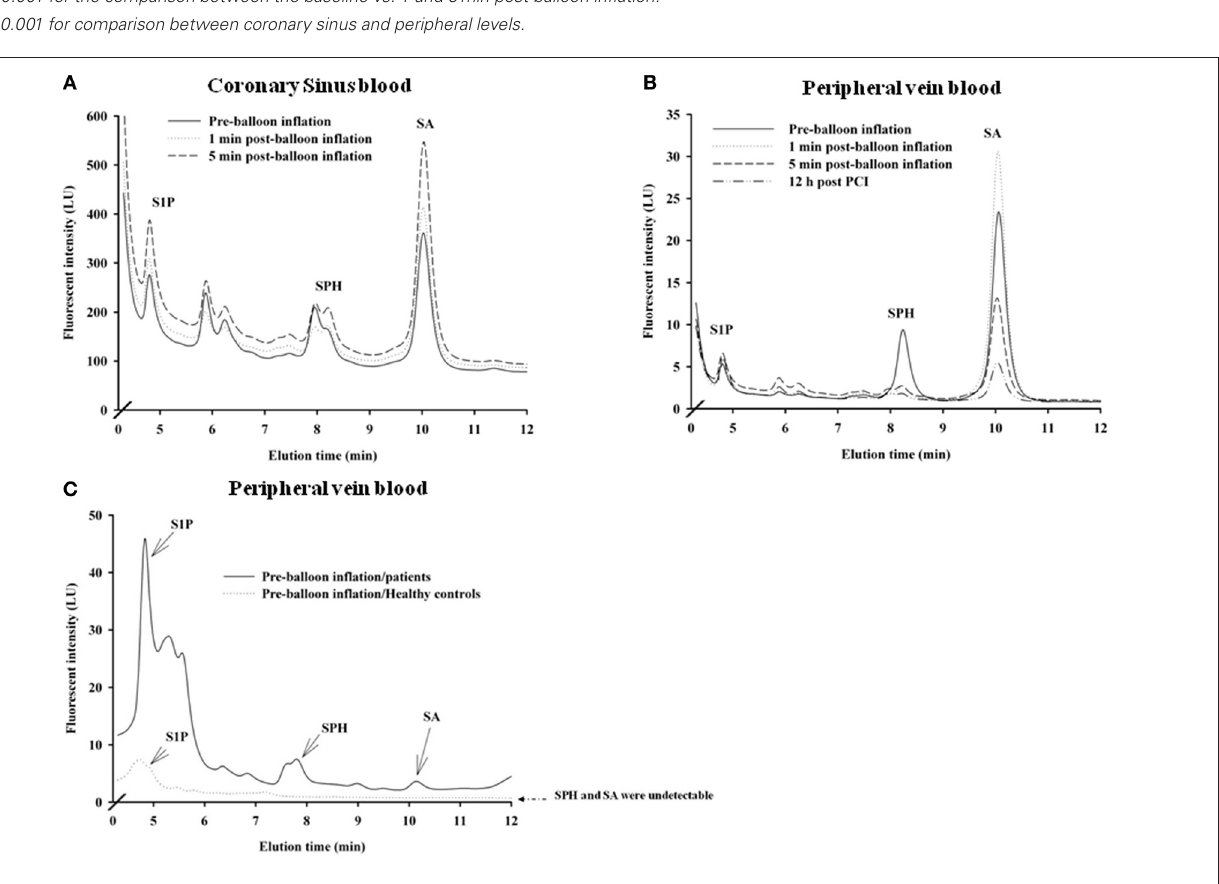
patient) and in a blood sample from a healthy control ( C ; n = 11). Representative examples of relative plasma levels of sphingolipids as detected by HPLC at baseline and at different time points: 1, 5min, and 12h post-PCI are